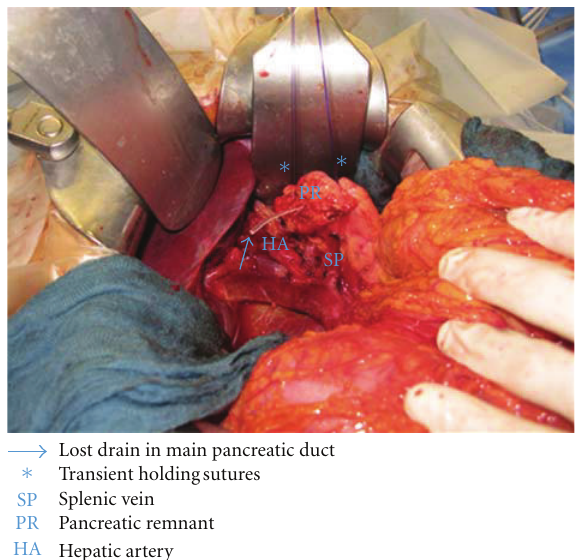
Figure 1: Mobilised pancreatic remnant with a lost drain inserted into the main pancreatic duct.